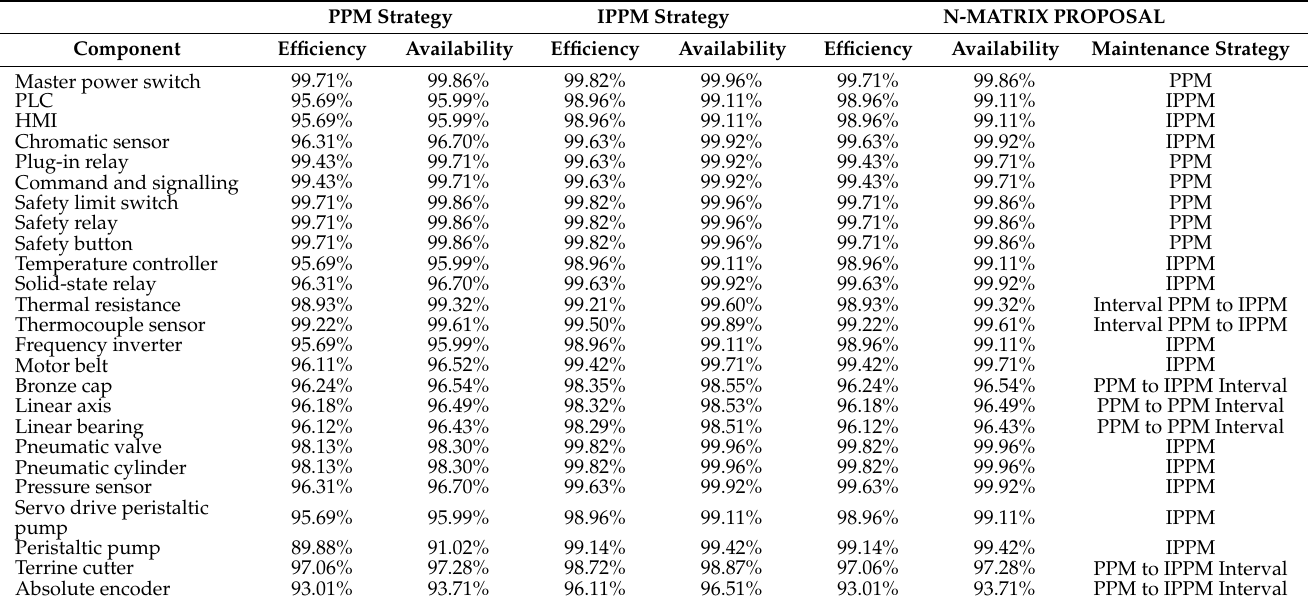
Table 15. Results and comparison of the application of n-dimensional matrix for maintenance strategy